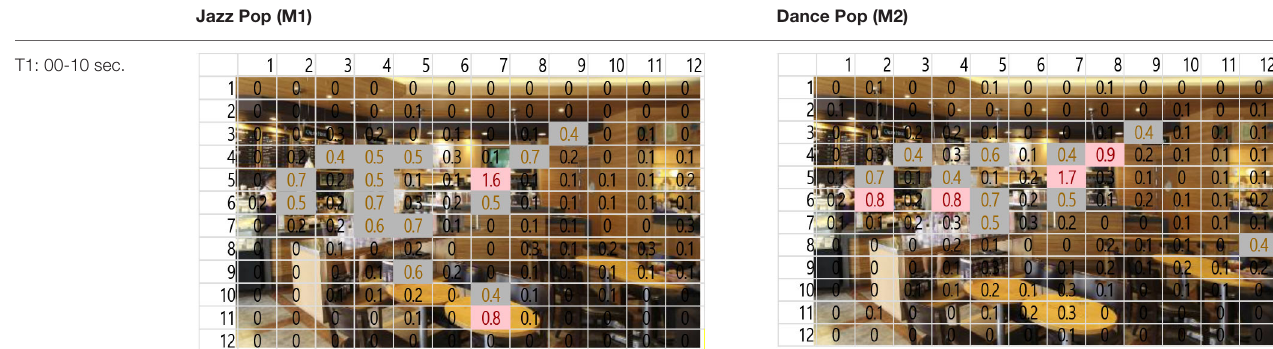
TABLE 1 | 12 × 12 gridded areas of interest (AOIs) of I-1, by music and time-segment (T1